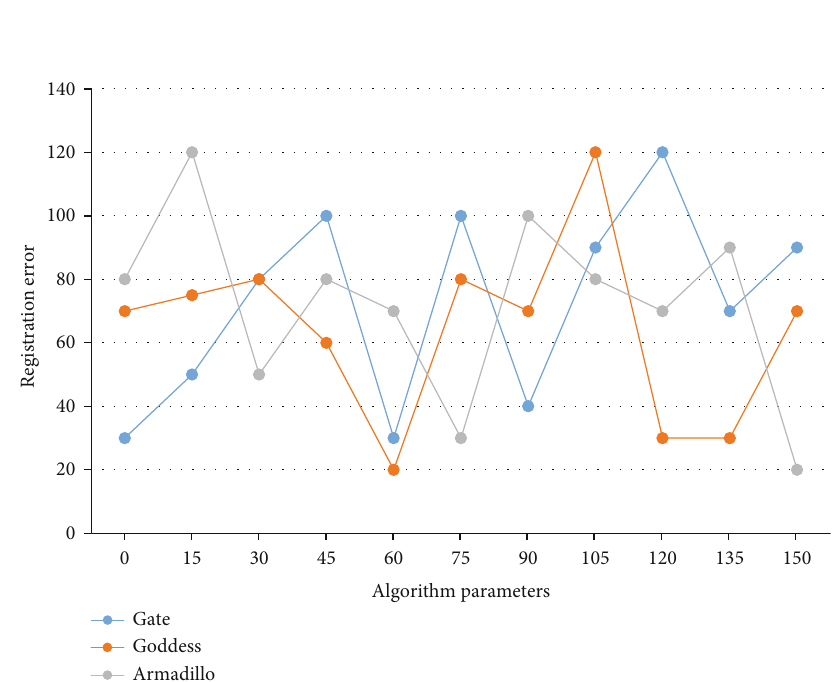
Figure 7: Bar chart of SAC-IA algorithm parameter